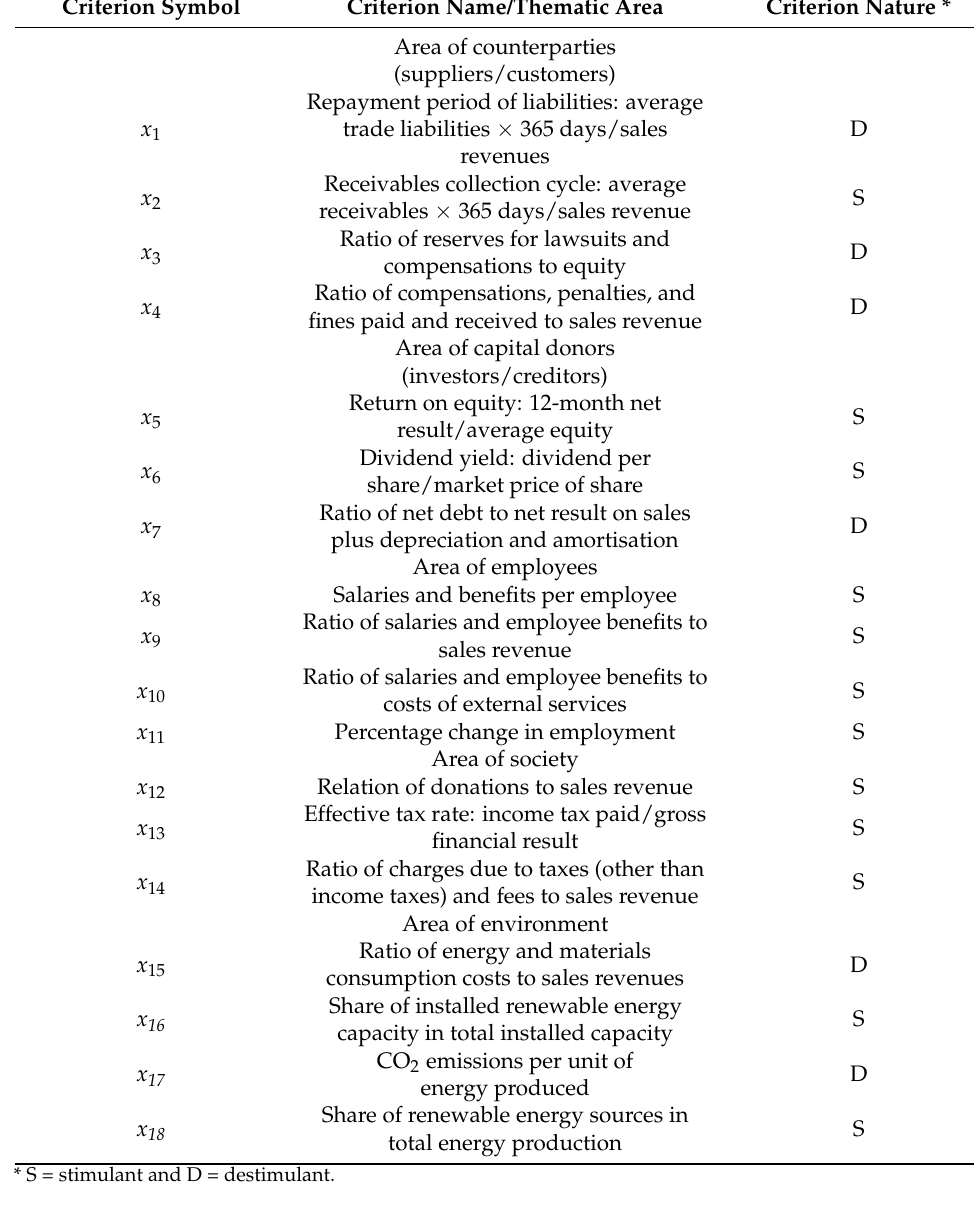
Table 1. Evaluation criteria for the different thematic areas of corporate social responsibility in the energy sector.